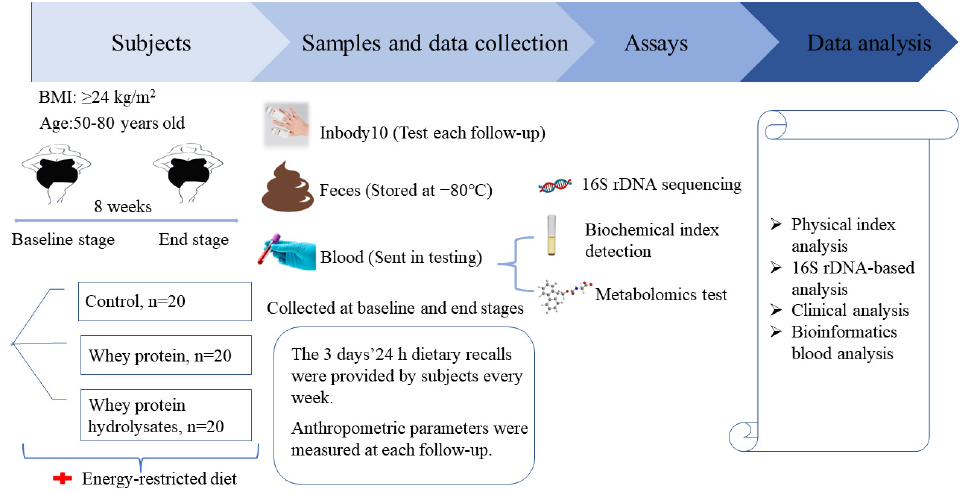
Figure 1. Experimental design.